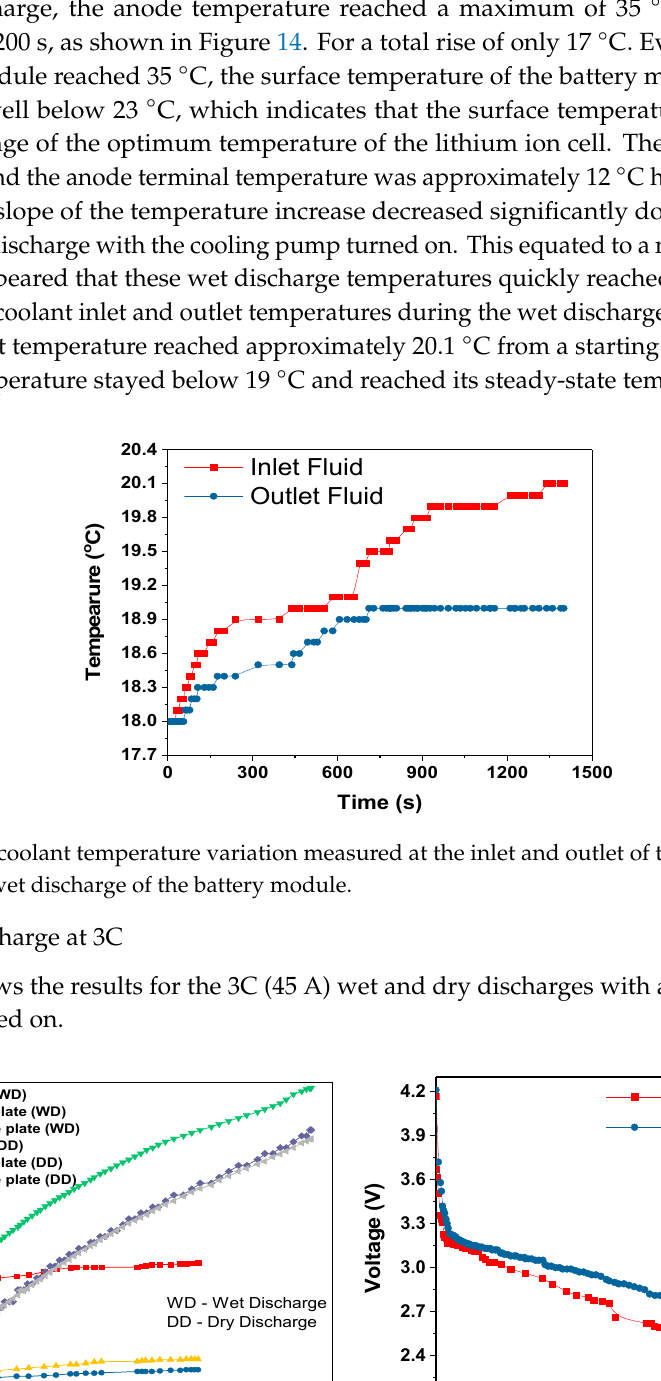
Figure 14. Measured voltage and temperature versus time for the six-cell battery module for the 2C wet and dry discharge rates, measured at various points in the module.